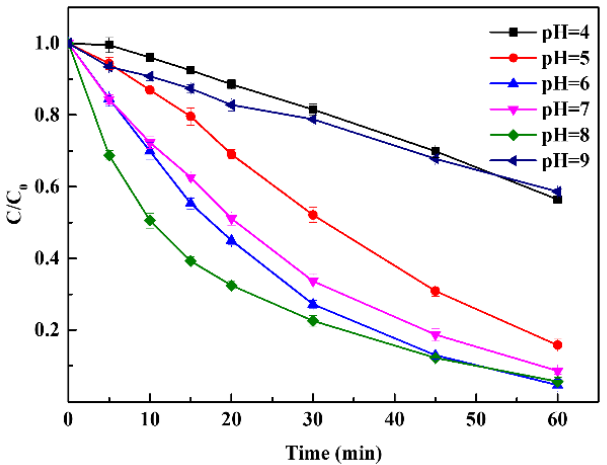
Figure 2. Effect of pH on Rhodamine B degradation (CuFe 2 O 4 = 100 mg/L, PAA = 40 mg/L, C 0 = 20 mg/L, room temperature for 1 h).